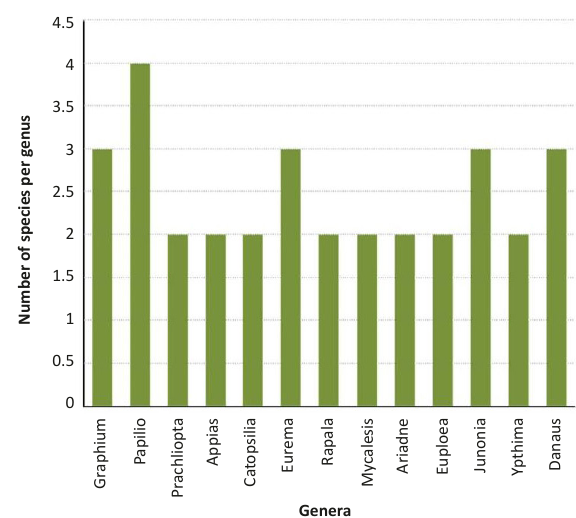
Figure 3. Most species-rich genera of butterflies of Sundarbans, comprising of two or more species hitherto recorded from this region.